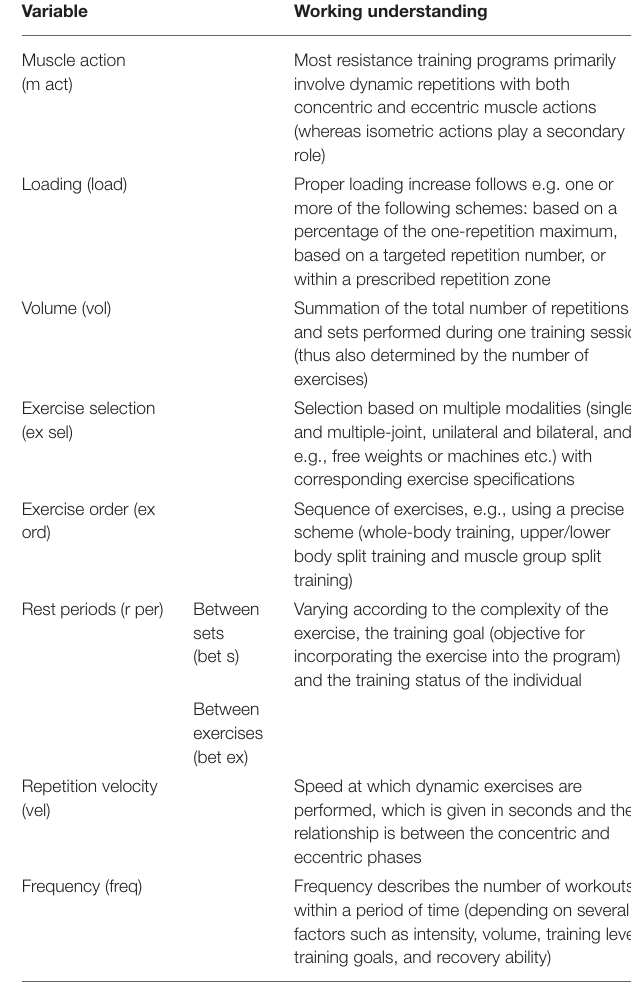
TABLE 2 | Variables of resistance training exercise prescription (working